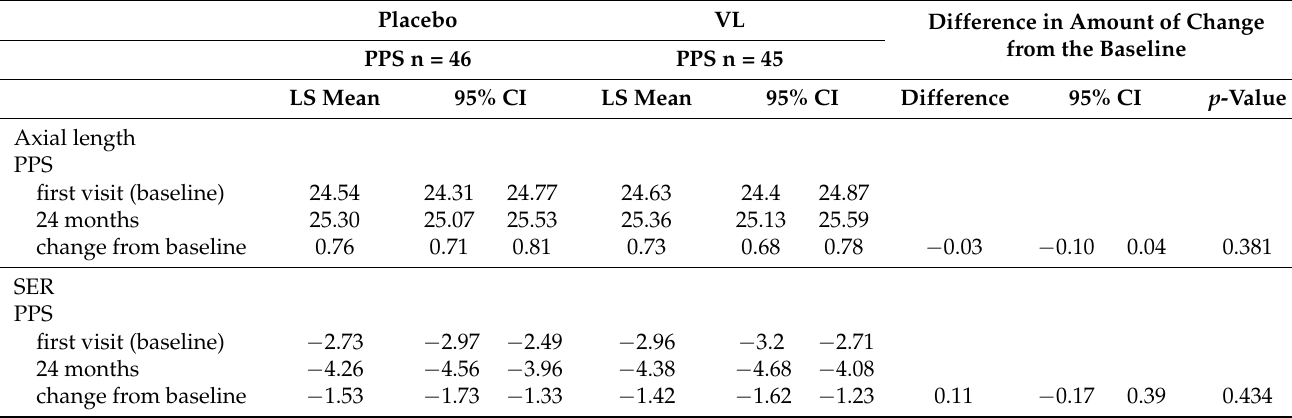
Table 2. Results of the mixed-effects model fitted to 24-month change for both